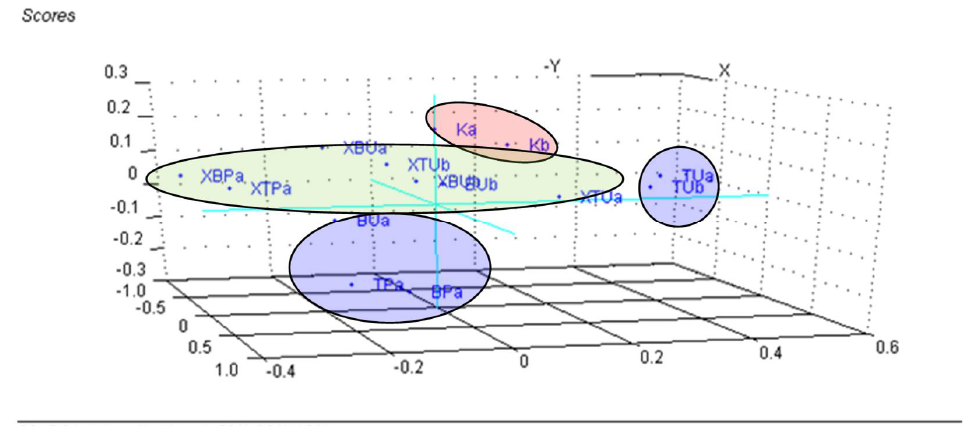
Figure 7. PC 3 versus PC 1 , PC 2 scores plot from the PCA analysis of all FTIR data (both intensities and wavenumbers) of the β-cyclodextrin/unprocessed and processed chicken breast and thigh lipid complexes (codes “XBU”, “XBP”, “XTU” and “XTP”), in comparison with β-cyclodextrin (code “K”) and non-complexed lipid fractions (codes “BU”, “BP”, “TU” and “TP”); “a” and “b” stand for du- plicate samples.